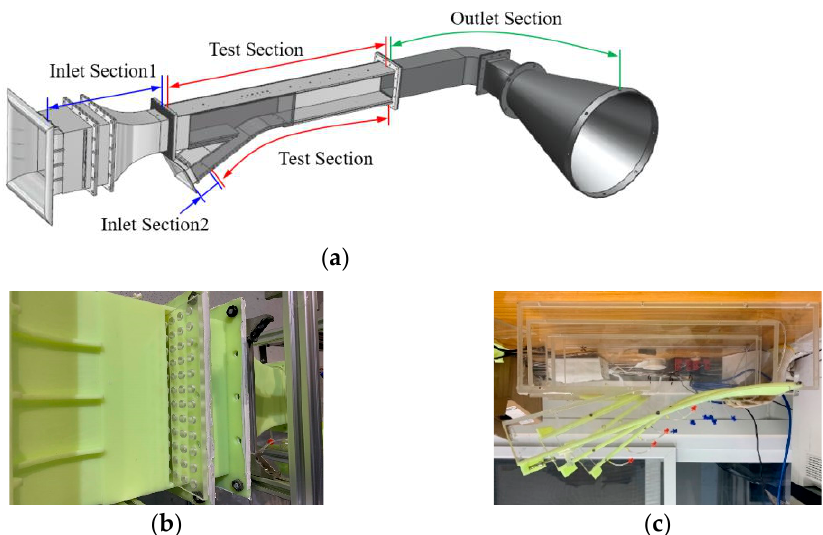
Figure 16. Schematic of the VABI test facility: ( a ) structure of the test rig; ( b ) the orifice control valve; ( c ) the replaceable inner bypass duct. Table 4. Variation range of the VABI test rig.